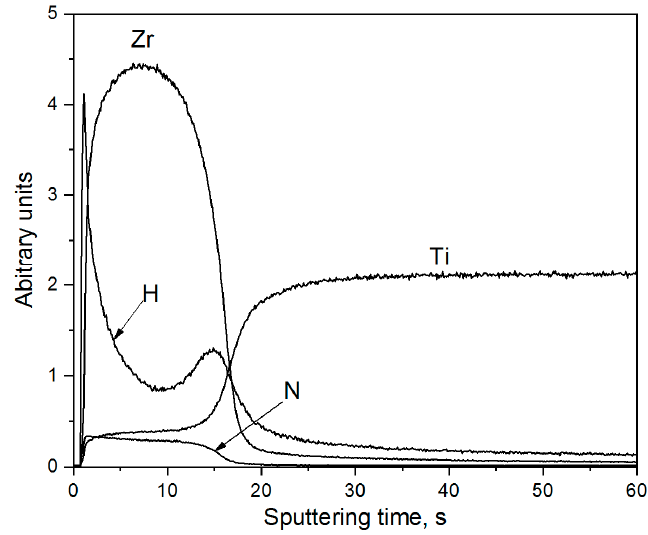
Figure 9. Element distribution profiles in the TZ2M specimens of the Ti0.16Pd with a δ —(Ti,Zr)N coating (ratio Zr/Ti = 1.28) after holding (430 h) at room temperature in air environment.